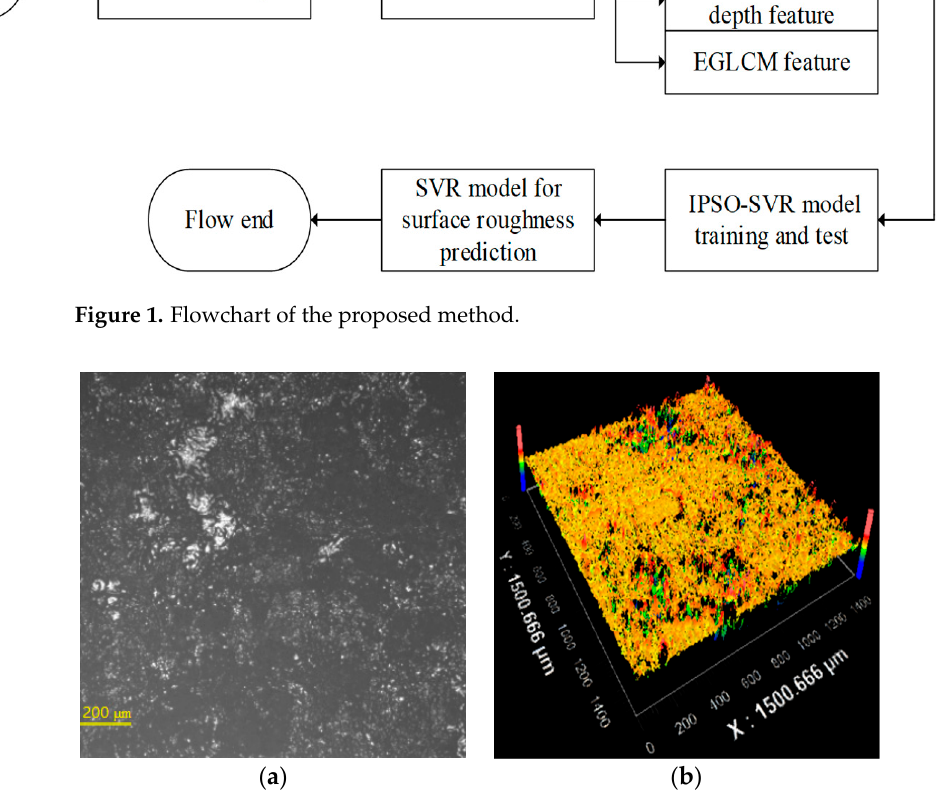
Figure 2. The 2D and 3D image samples after laser cleaning: ( a ) 2D image sample; ( b ) 3D image sample.